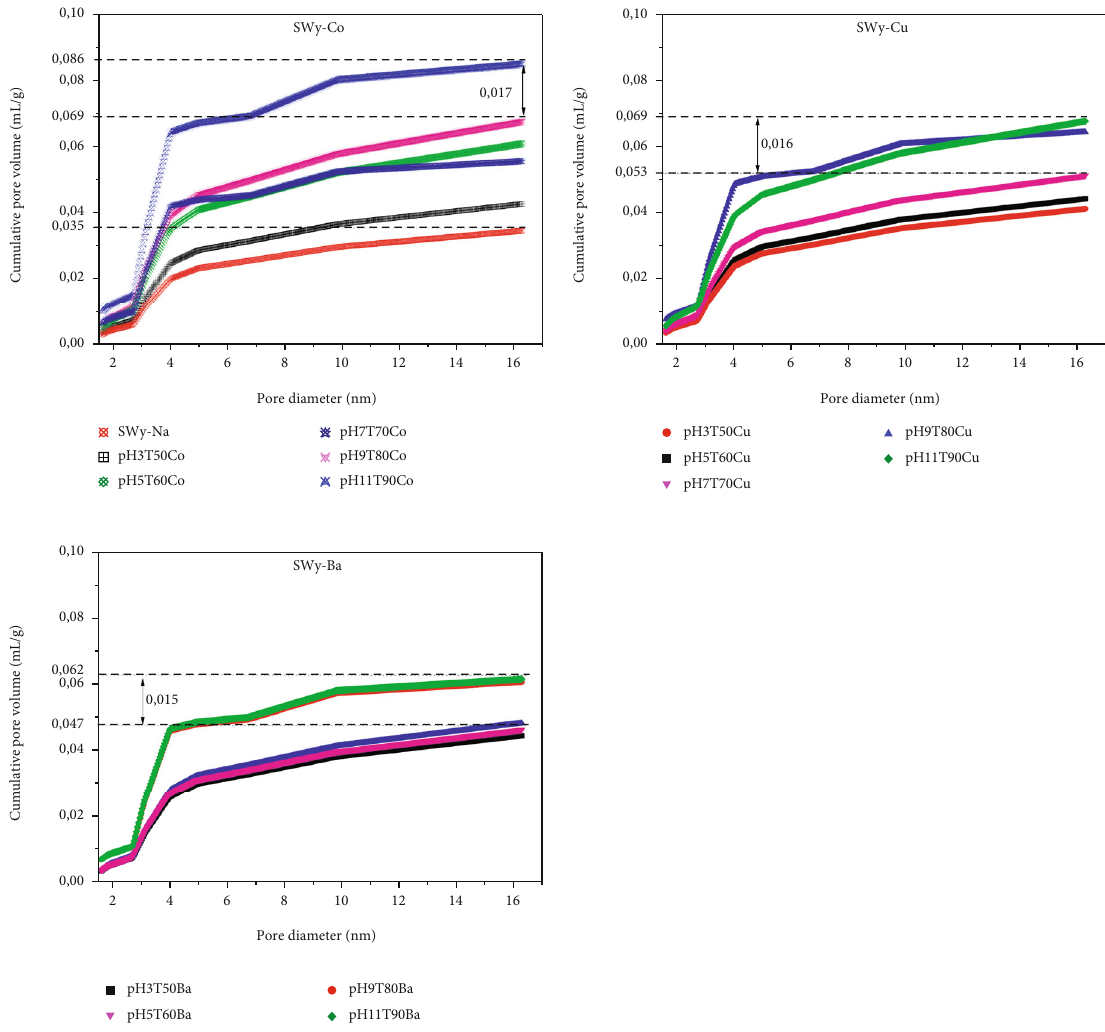
Figure 15: The pore size distribution (PSD) curve for the di ff erent studied samples ( V - r ) in the case of SWy-Co, SWy-Cu, and